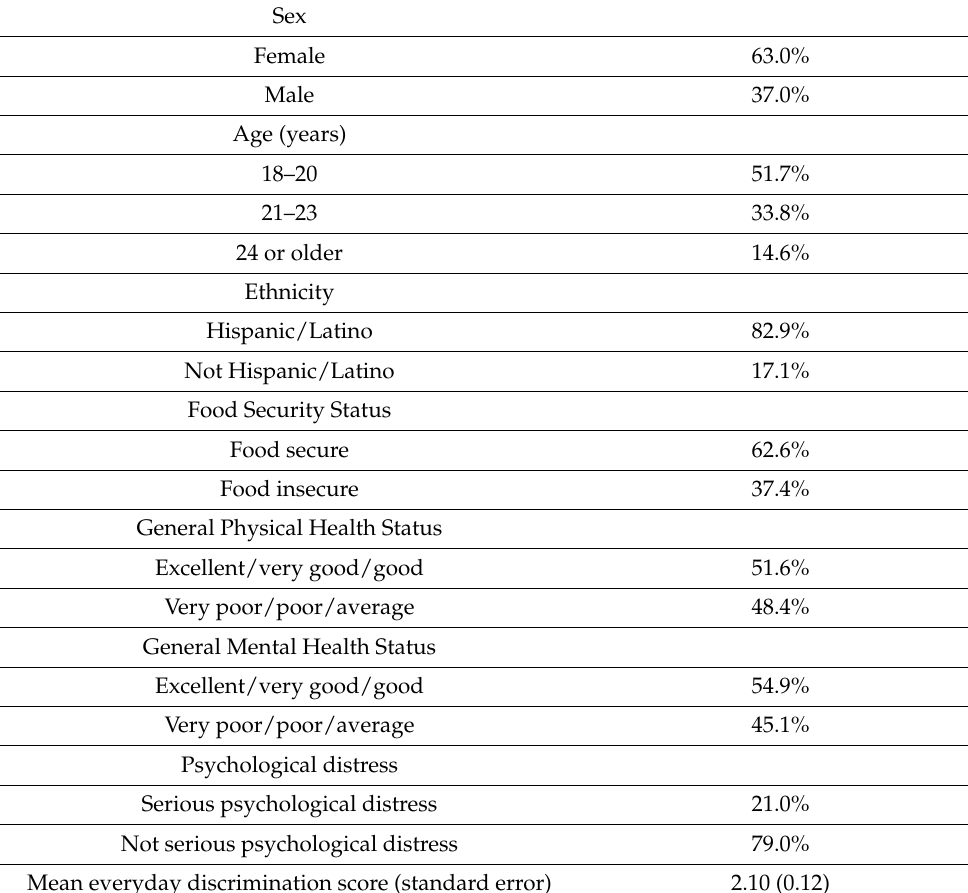
Table 1. Study population characteristics (n =